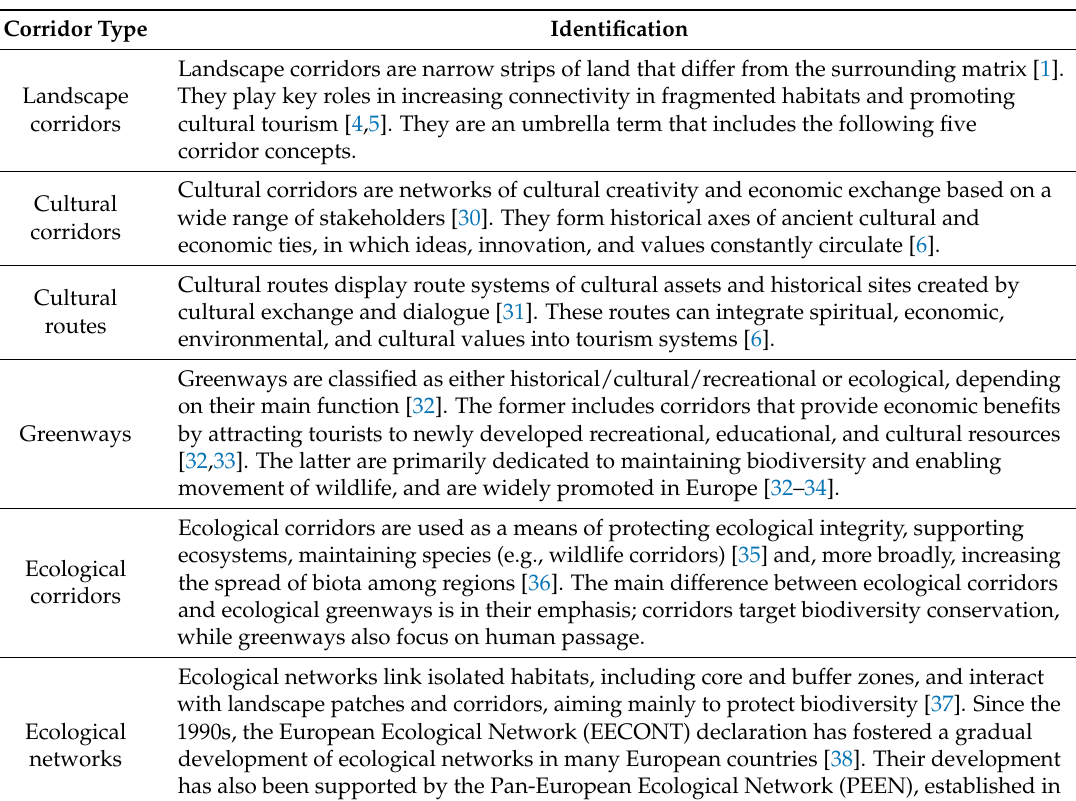
Table 1. Identification of corridor concepts used as